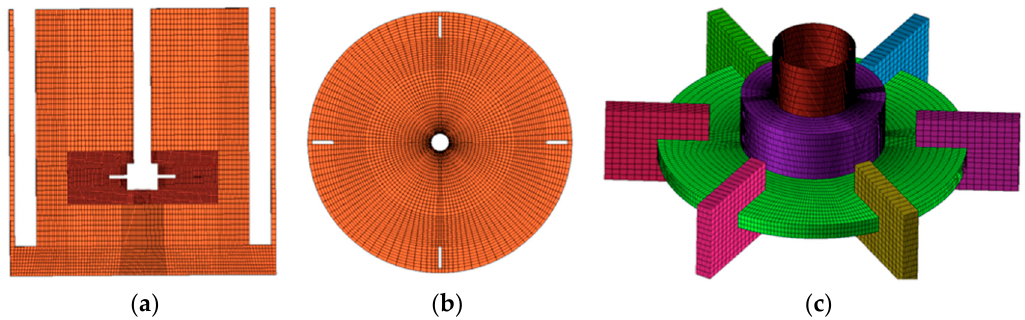
Figure 3. View of the hexahedral mesh. ( a ) vertical section; ( b ) horizontal section; ( c ) impeller surface.